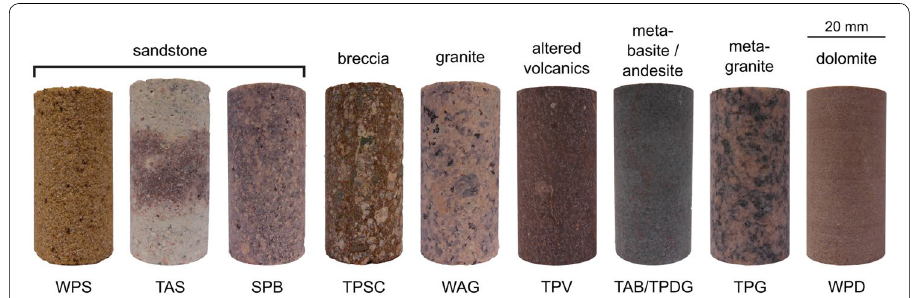
Fig. 3 Photos of the rock samples prepared for physical property characterisation. WPS sandstone from Raon l’Etape, TAS sandstone from Waldhambach, SPB sandstone from Saint Pierre Bois, TPSC breccia